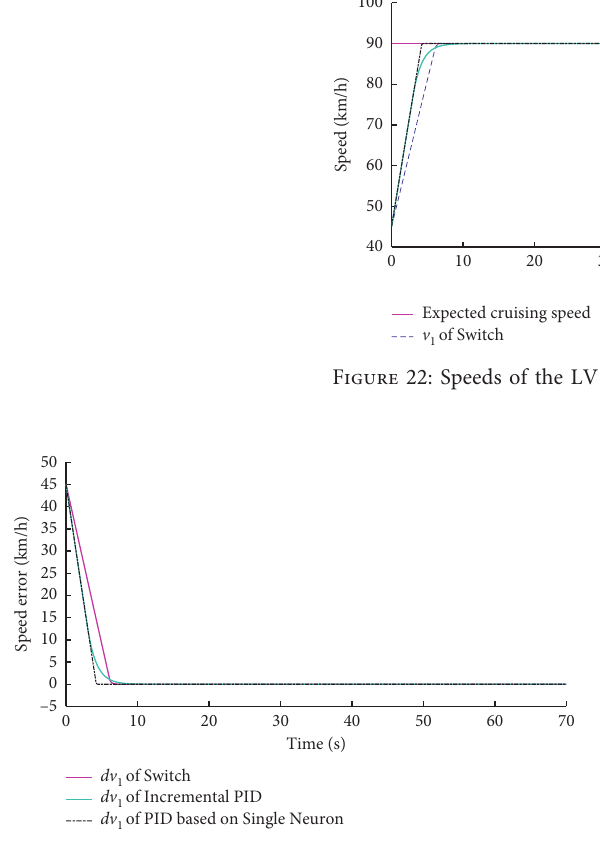
Figure 23: Speed errors of the LV and the FV of three